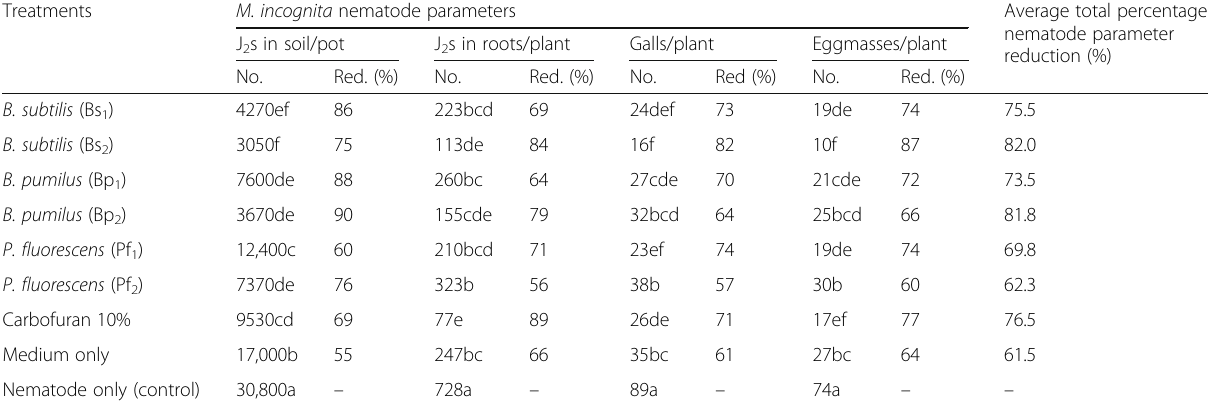
Table 1 Effects of Bacillus subtilis , B. pumilus , and Pseudomonas fluorescens isolates on Meloidogyne incognita reproductive parameters on cowpea grown under screen house conditions